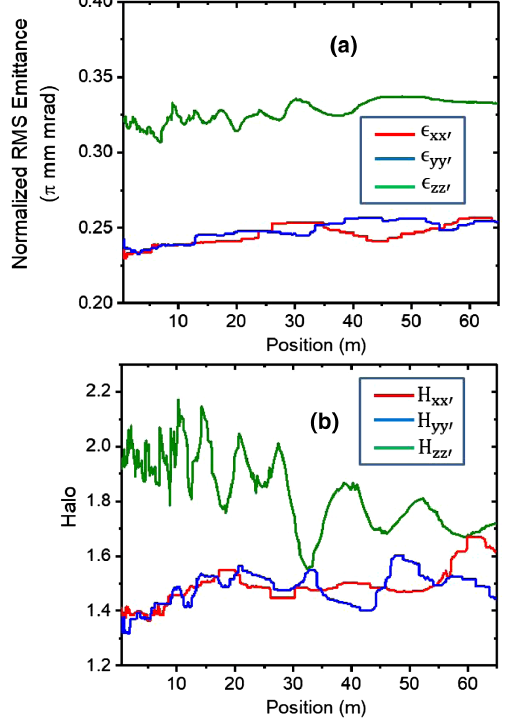
FIG. 38. (a) Transverse and longitudinal rms normalized emittance, and (b) transverse and longitudinal beam halo param- eter along the SC section of the MEHIPA linac.